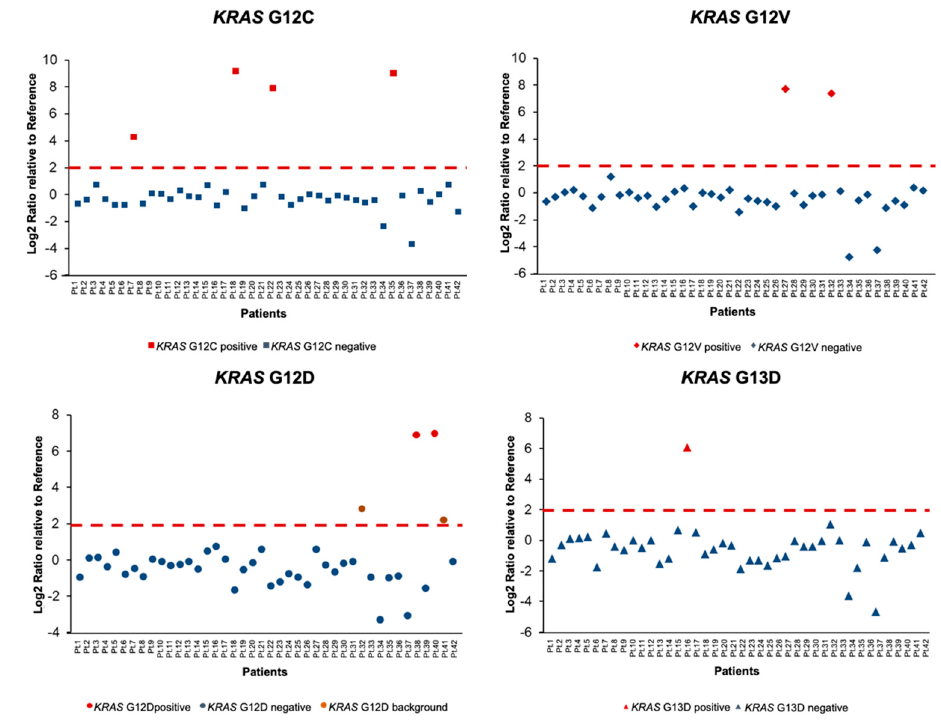
Figure 3. Normalized KRAS values for the 42 patients analyzed with nCounter platform. Pt: patient.